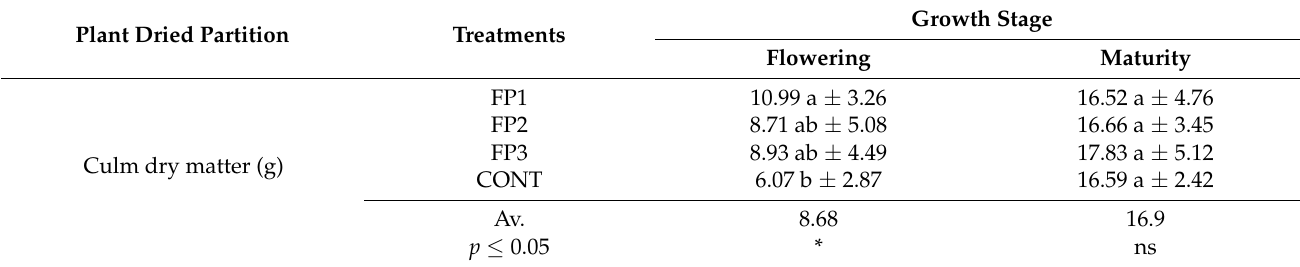
Table 3. The culm, leaf, panicle, and total dry matter accumulation of rice plants at the flowering and maturity stages following treatments combining chemical fertilizer and plant-growth-promoting rhizobacteria. Plant Dried